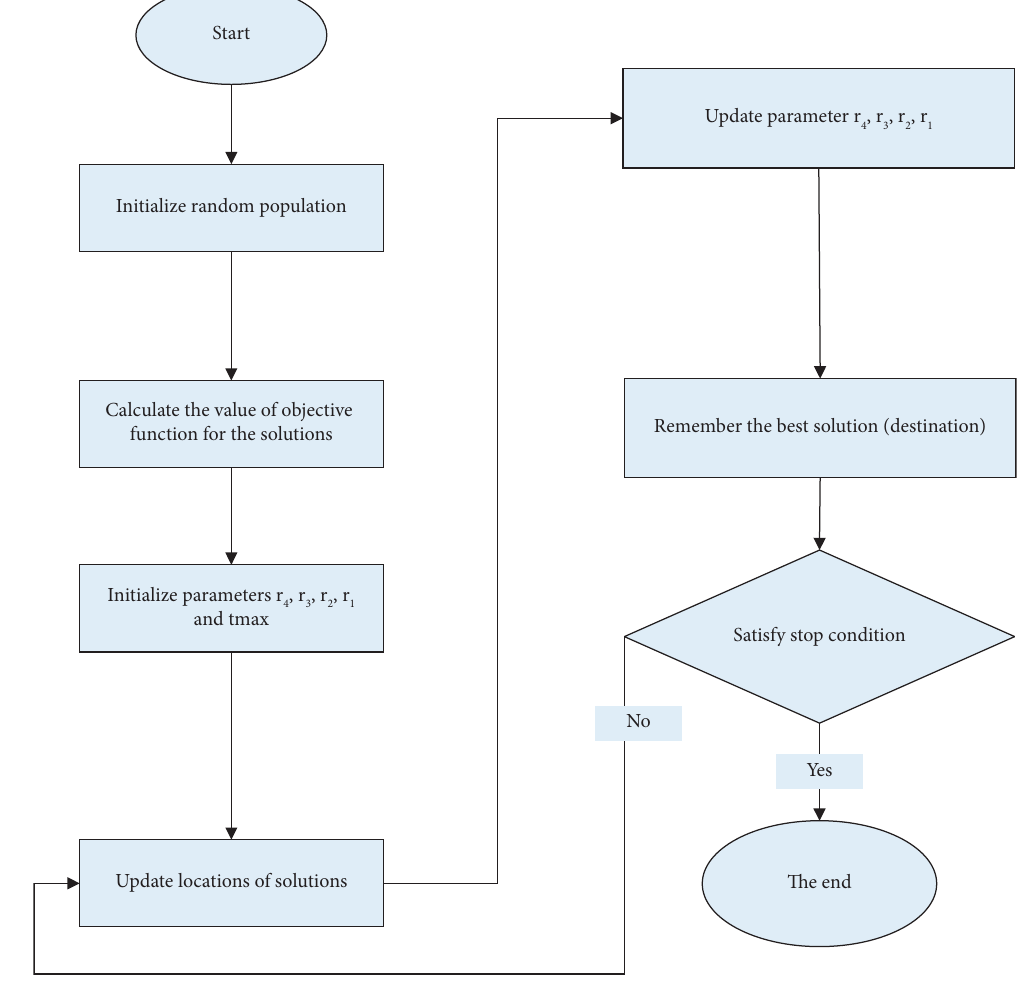
Figure 5: Te fowchart of SCA algorithm.